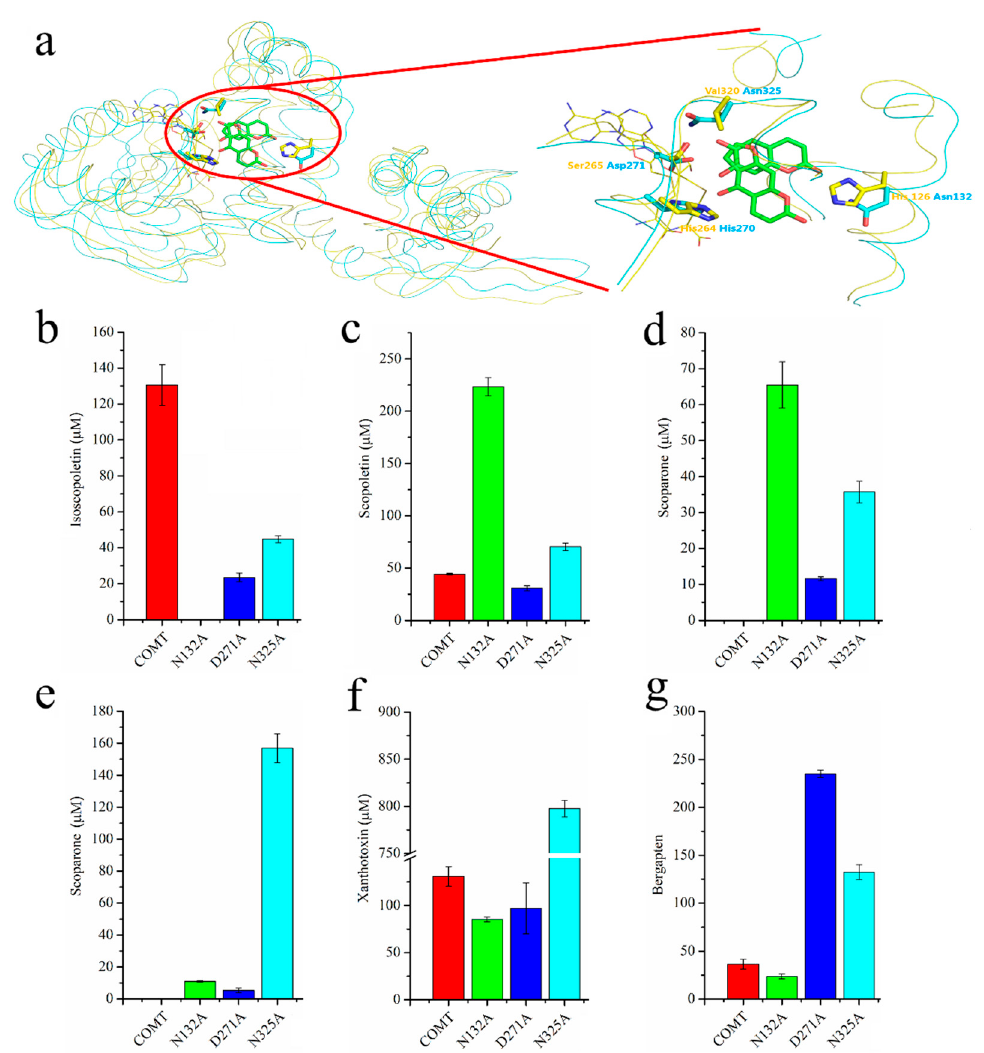
Figure 6. The structure comparison of PpBMT with COMT-S and their mutants towards different hydroxylated coumarins. ( a ) The structure comparison of PpBMT with COMT-S and its local enlarged form. A relatively high similarity was observed in BMT and COMT-S indicated that COMT –S could catalyze bergaptol structurally. The colors of BMT and COMT-S are yellow and blue, respectively. ( b – g ) COMT-S (and its mutants N132A, D271A, N325A) in catalyzing esculetin ( b , c ), isoscopoletin ( d ), scopoletin ( e ), xanthotoxl ( f ) and bergaptol ( g ) to produce isoscopoletin ( b )/scopoletin ( c ), scoparone ( d , e ), xanthotoxin ( f ) and bergapten ( g ), respectively.